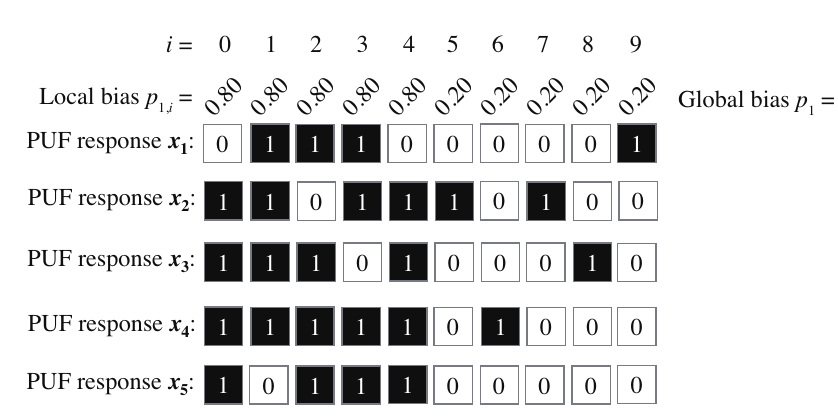
Figure 1: Sample global and cell-wise bias models.